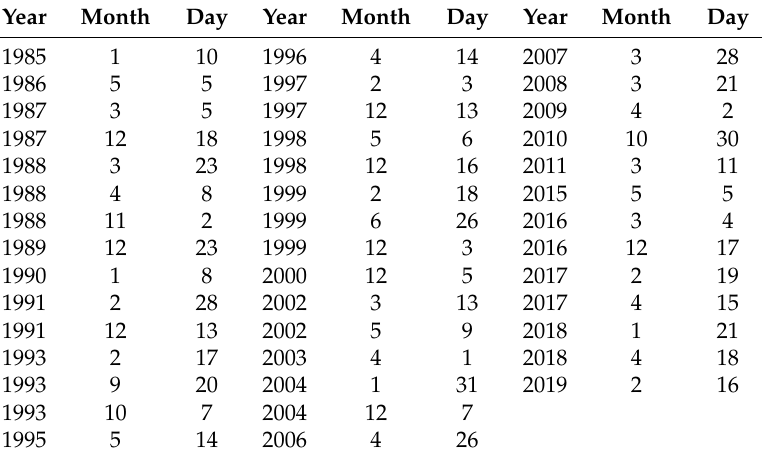
Table 2. Landsat satellite image used in the